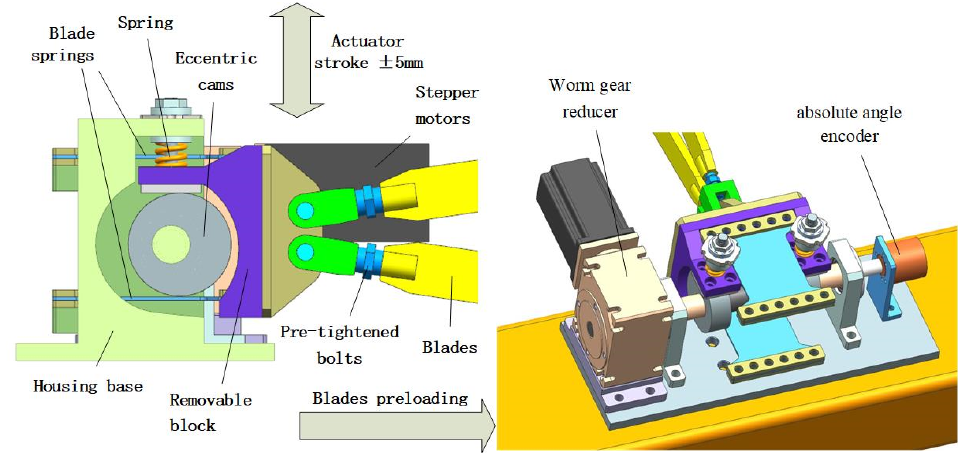
Figure 5. Correction unit mechanism.